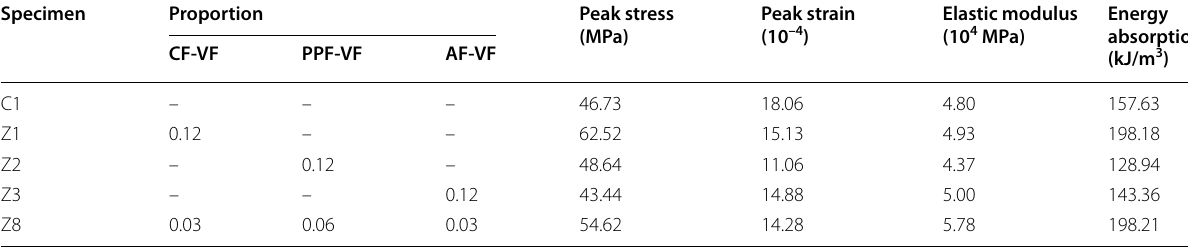
Table 6 Characteristic values of compressive stress–strain curves. Specimen